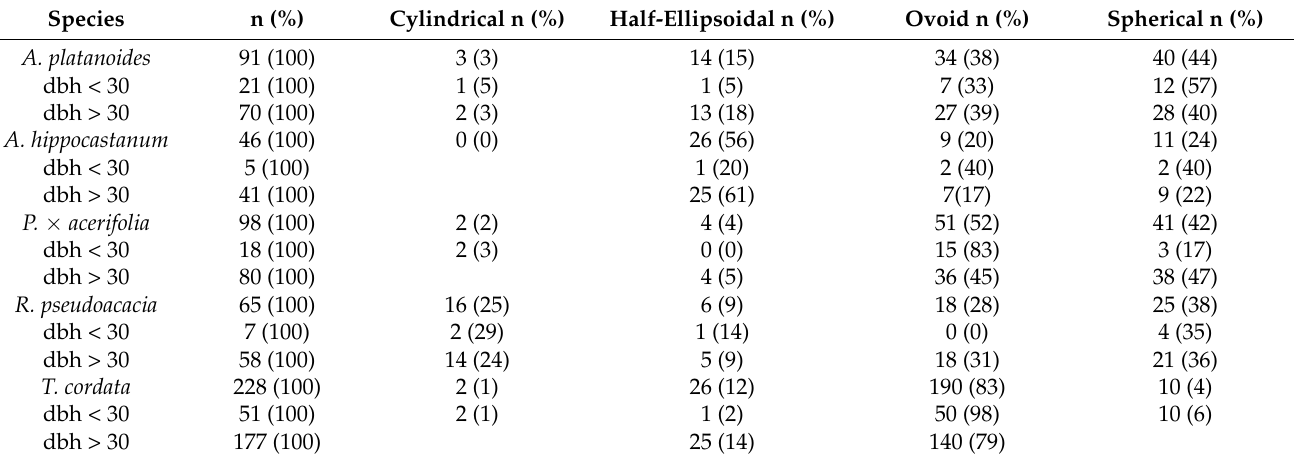
Table 5. Observed distribution of different crown shapes according to species and age, n—number of